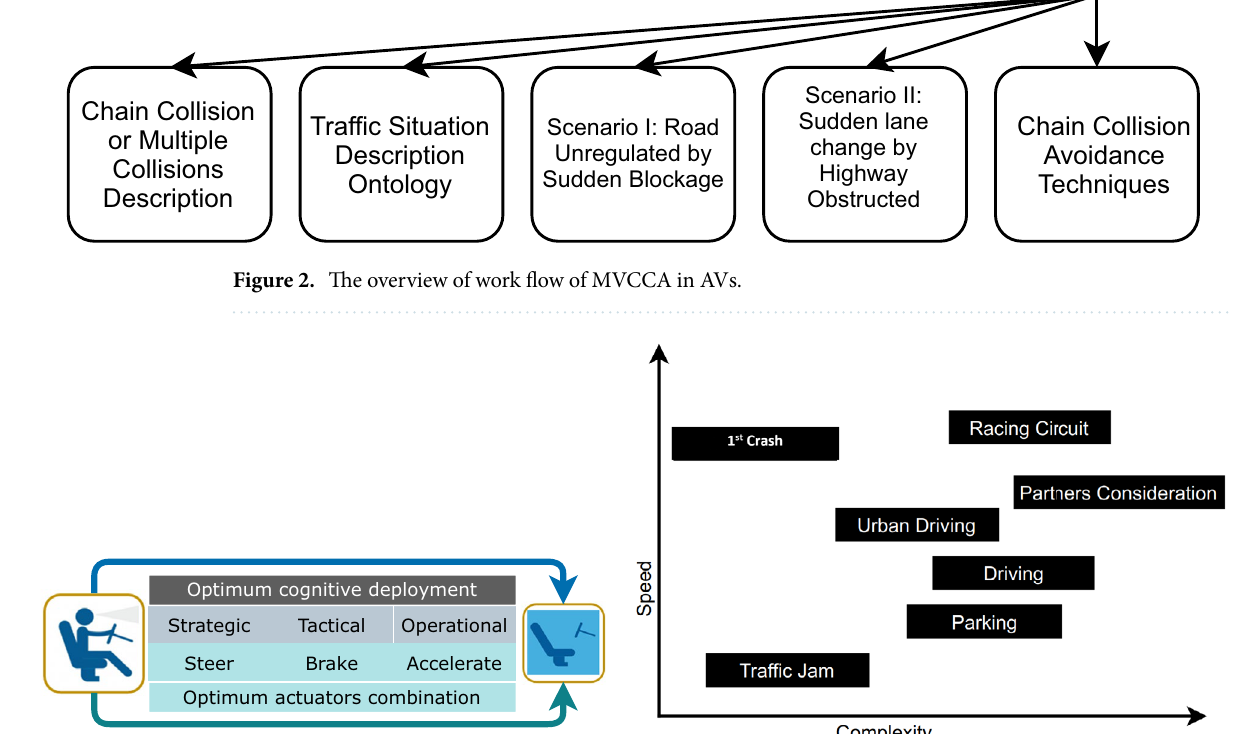
Figure 3. Evaluations of driving complexity in